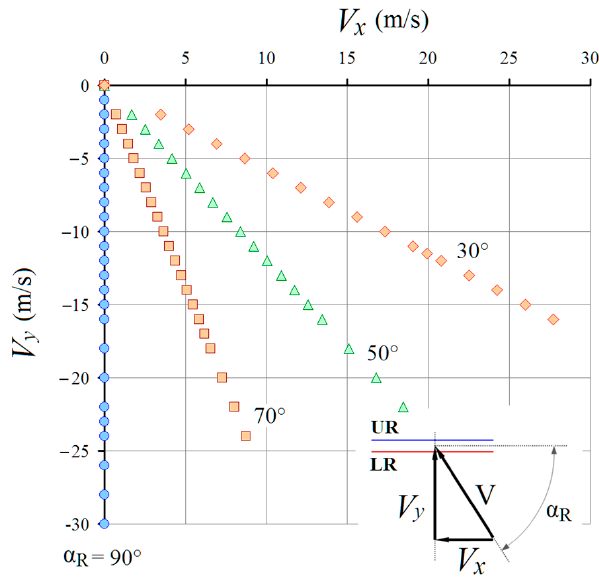
Figure 3. Grid of computational modes.